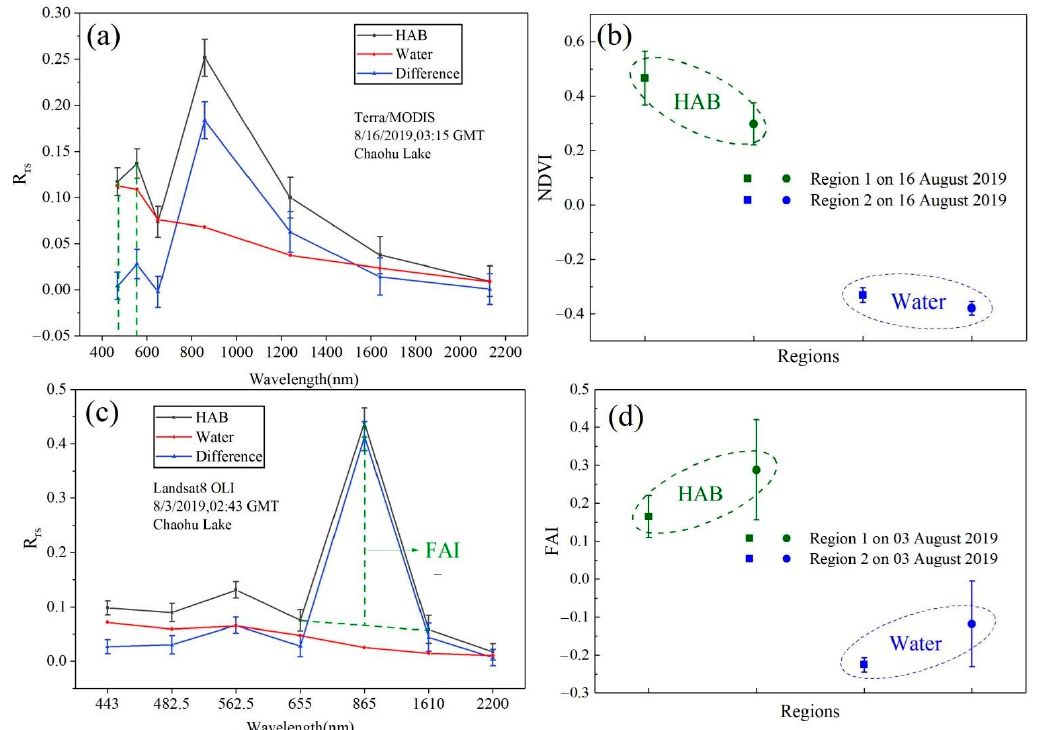
Figure 5. The interpretation of the algorithm and the results of each algorithm’s reflectivity diagram ( a , c , e ) are the reflectances of a harmful algal bloom (HAB) and a nearby non-HAB lake, and ( b , d , f ) are means and standard deviations of HAB and non-HAB water lake reflectance. For the two regions of MODIS, Landsat8, and Sentinel-2 150 × 150 image pixels with 9359 × 9459, 7651 × 7791, and 0980 × 10,980 HAB classification pixels